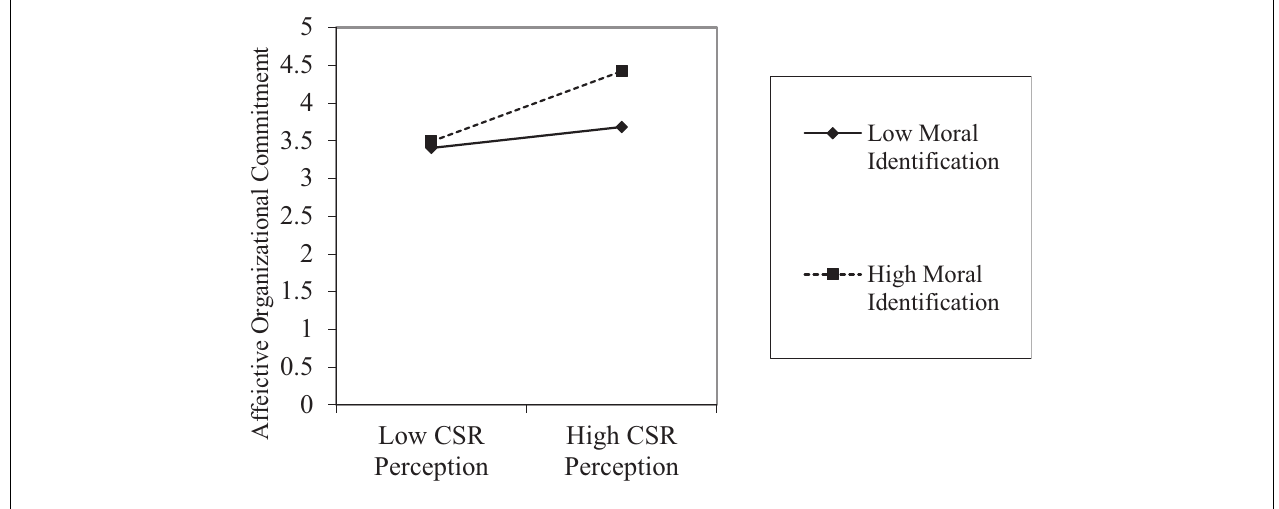
FIGURE 2 | Moderating effects of moral